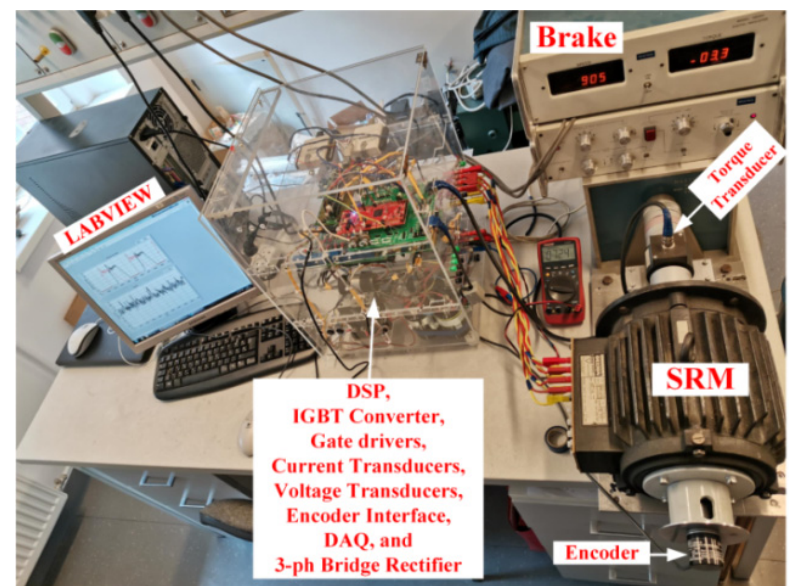
Figure 13. Photograph of the experimental testbed.